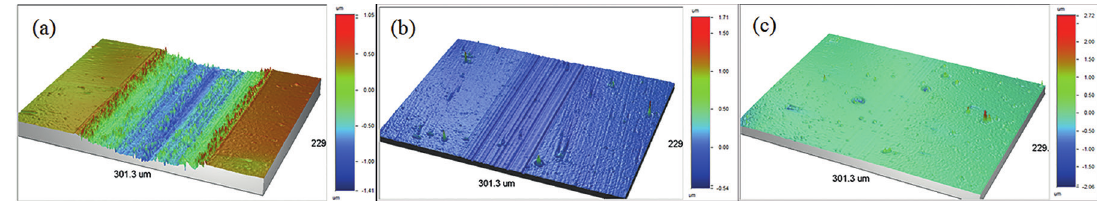
Figure 8: Wear track profiles of (a) uncoated, (b, c) DLC-coated steel.